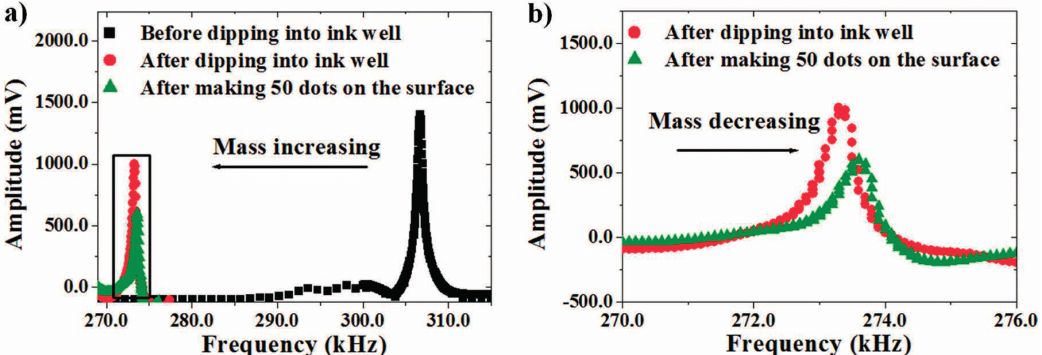
Figure 10. ( a ) Decrease in the resonance frequency of the cantilever before and after dipping in the solution (black squares to red circles). Increase in the resonance frequency after dispensing 50 droplets (red circles to green triangles). ( b ) Closer view of the increase in the frequency after a mass equivalent of 50 dots is released from the cantilever. Reprinted with permission from